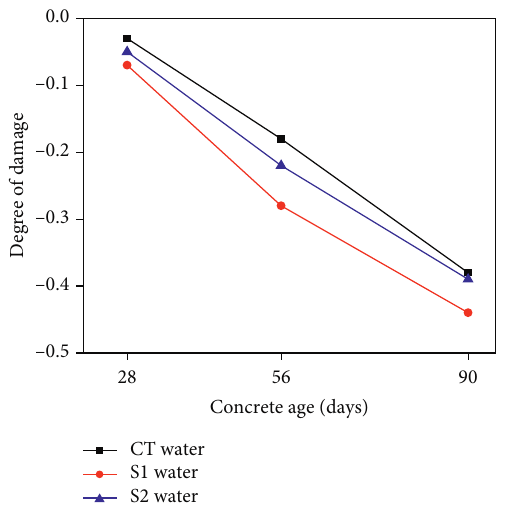
Figure 11: Degree of damage of CT, S1, and S2 immersed in the chloride solution.